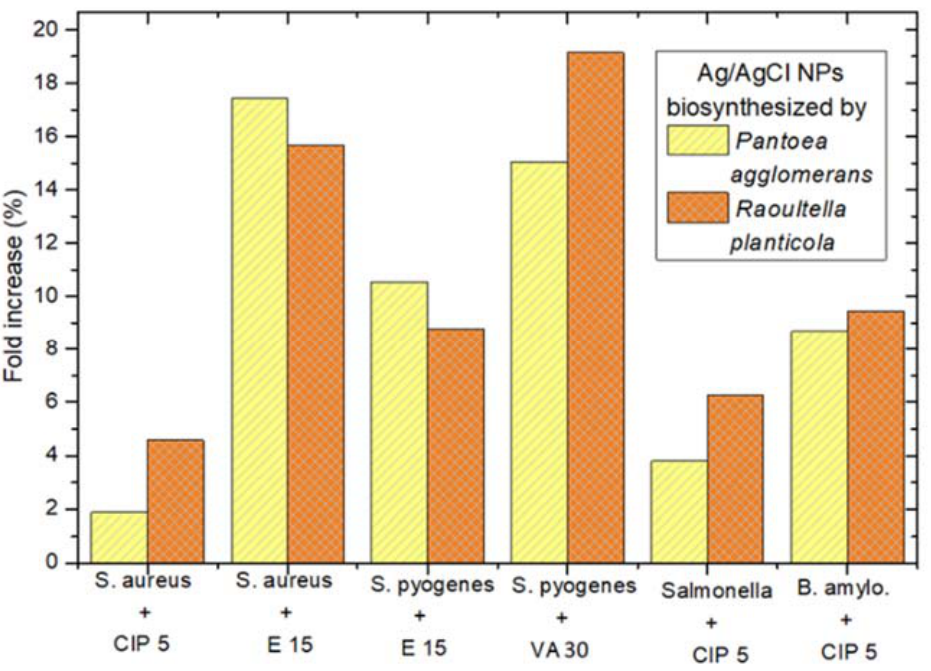
Figure 7. Percentage increase in the antibacterial effect of antibiotics with AgCl NPs against the tested strains.